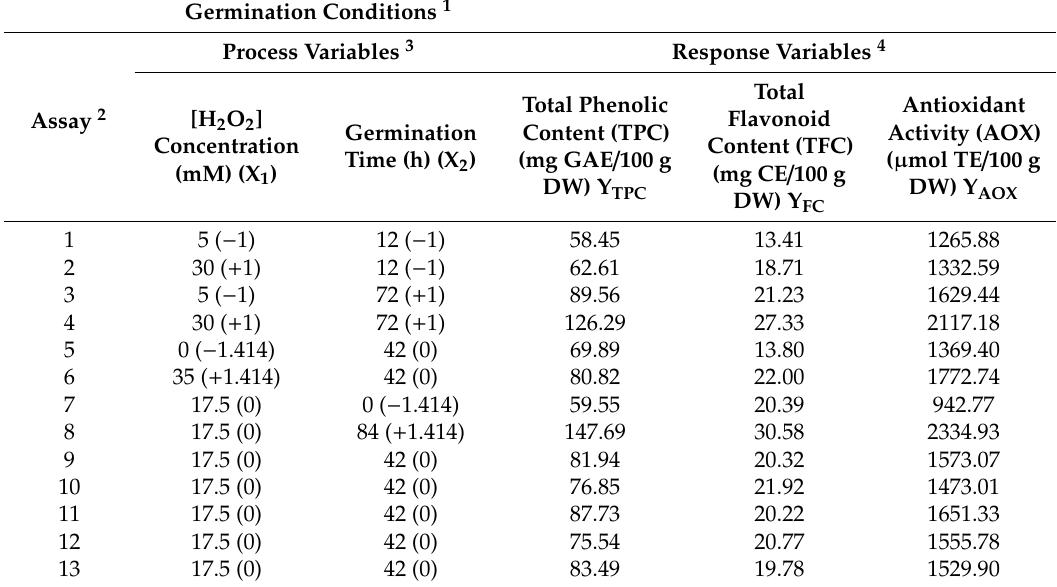
Table 1. Experimental result of response variables evaluated in the chickpea sprouts produced at di ff erent combinations of (H 2 O 2 ) concentration / germination